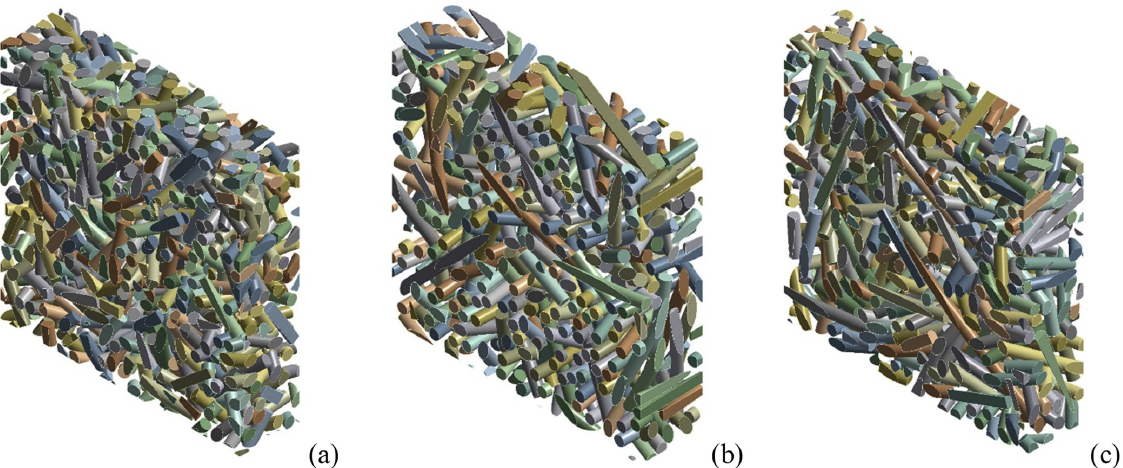
Figure 8. RVE of epoxy resin-short sisal fiber composites with V f = 0.35 and variable mean fiber length: ( a ) 1 mm, ( b ) 4 mm, ( c ) 8 mm.